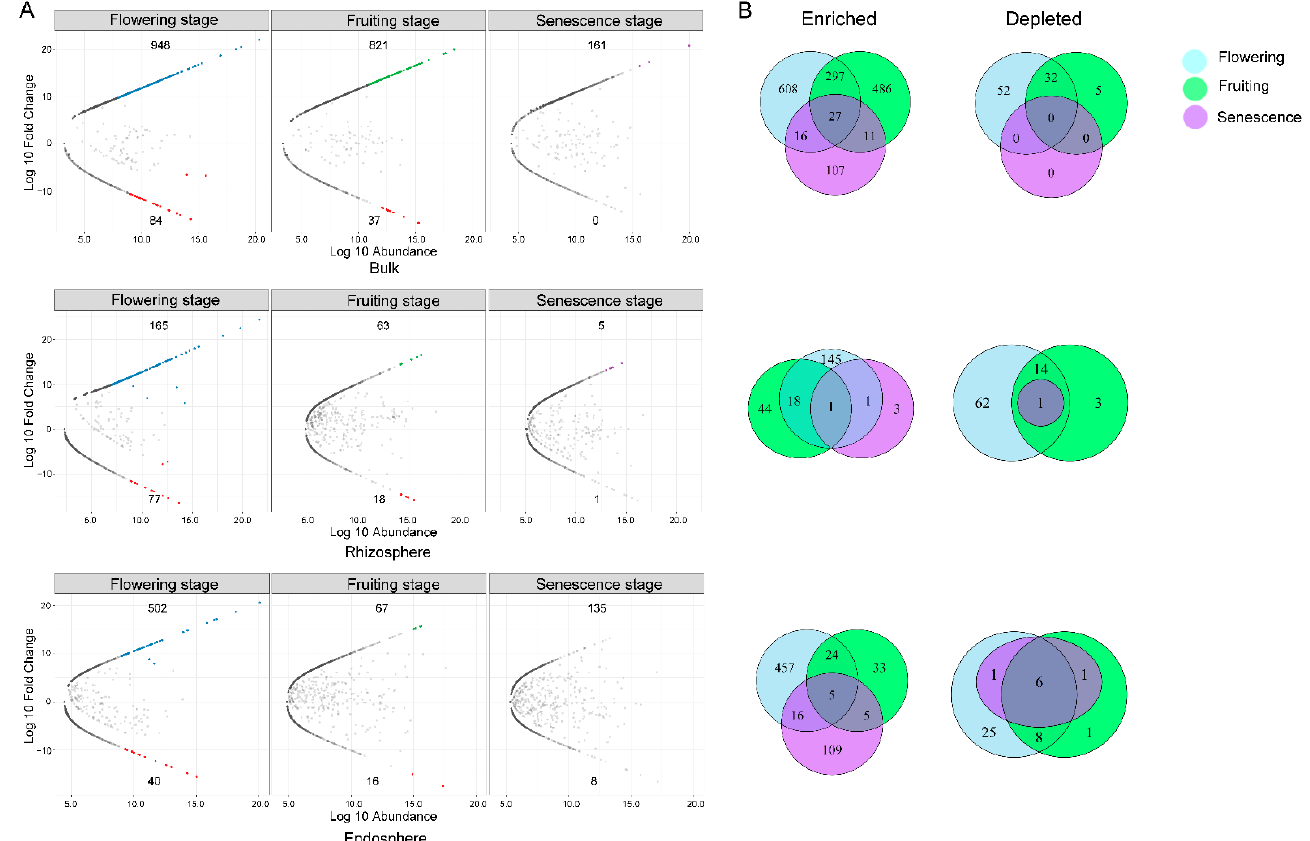
Figure 9. Fungal community comparison between the four growth stages in each root compartment. ( A ) MA diagrams show the enrichment and depletion of 18S OTUs for each growth stage (flowering stage, fruiting stage, and senescence stage) compared with the vegetative stage in three rhizocompartments. Each point represents an individual OTU, of which the blue, green, and purple points represent enriched OTUs in flowering stage, fruiting stage, and senescence stages compared to the vegetative stage, while the red ones indicate depleted OTUs, and the grey points represent no difference in abundance. The position along the y axis represents the abundance fold change compared with the bulk soil. ( B ) Venn diagrams illustrate the numbers of differentially enriched and depleted OTUs between each stage compared with the vegetative stage.